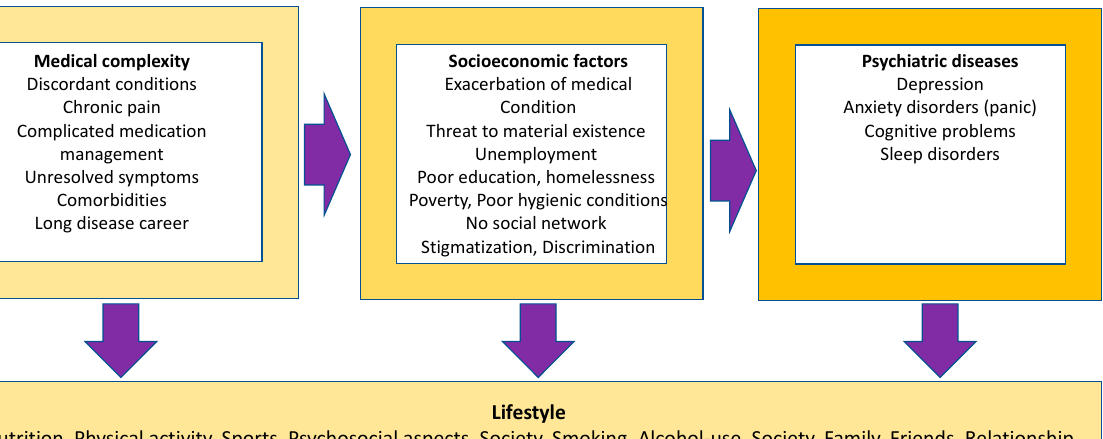
Figure 3. General complexity of people with chronic diseases (own presentation).